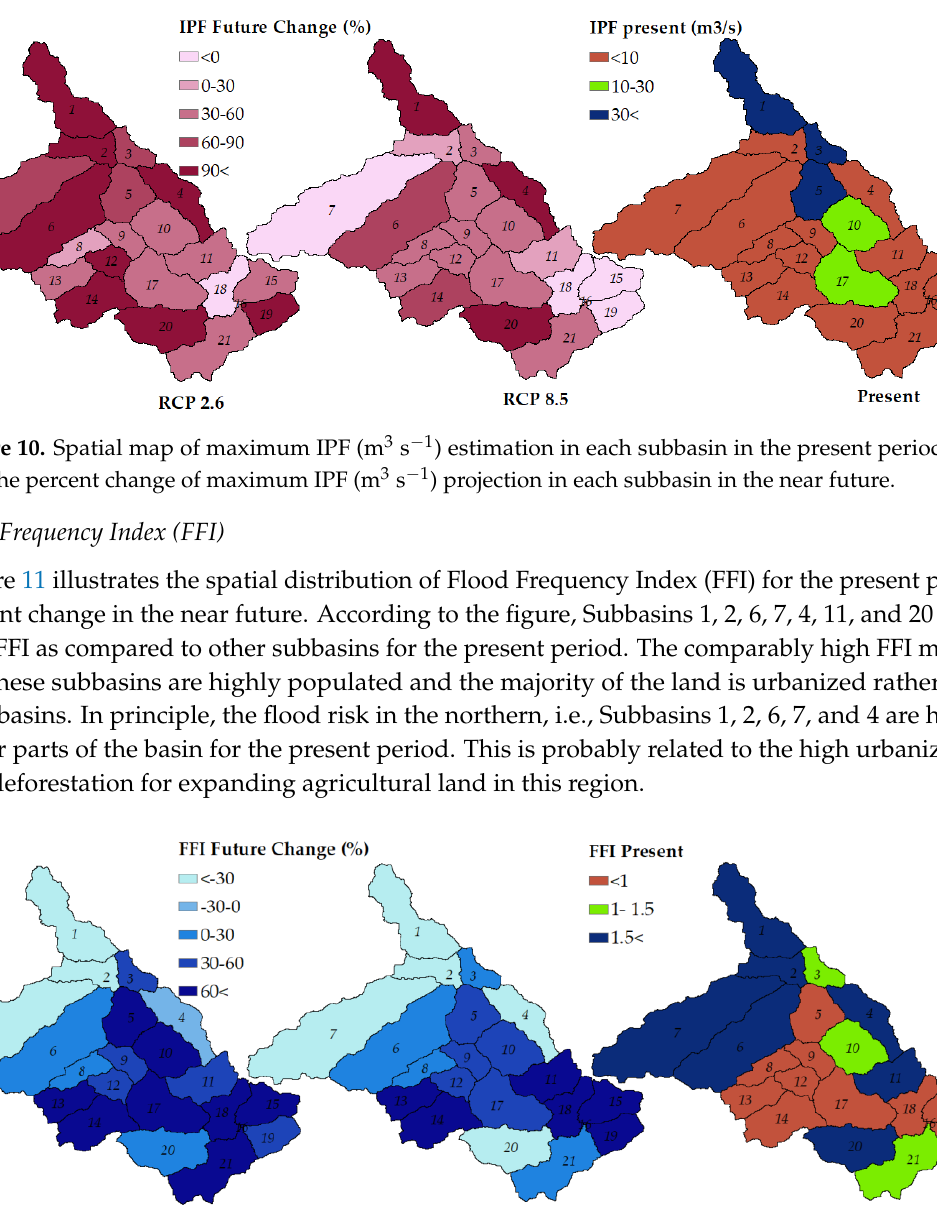
Figure 11. Flood Frequency Index (FFI) for the present period in each subbasin and percent change of FFI in each subbasin in the near future.